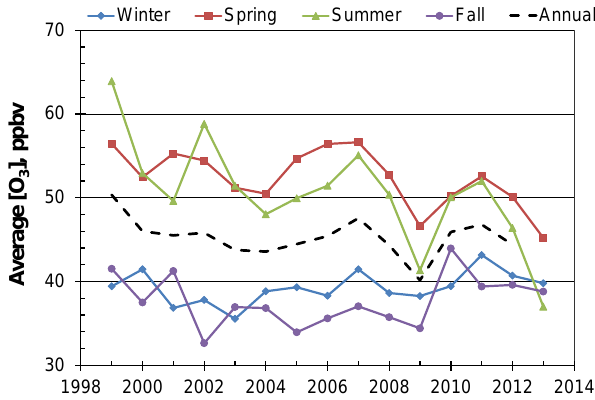
Figure 3. Ozone trends by season and annually at Look